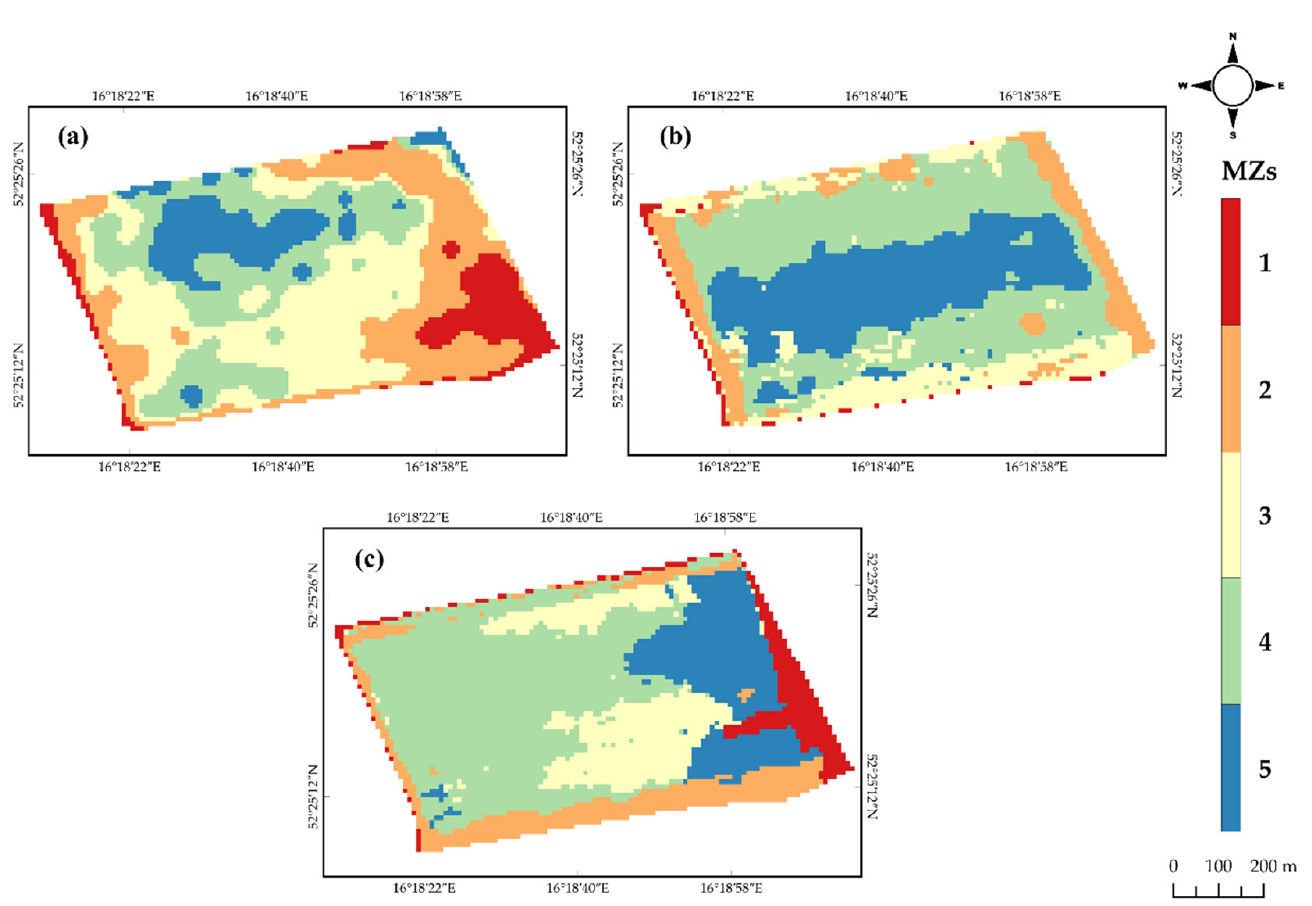
Figure 5. Delineated MZ maps of model-1 ( a ), model-2 ( b ) and model-3 ( c ).